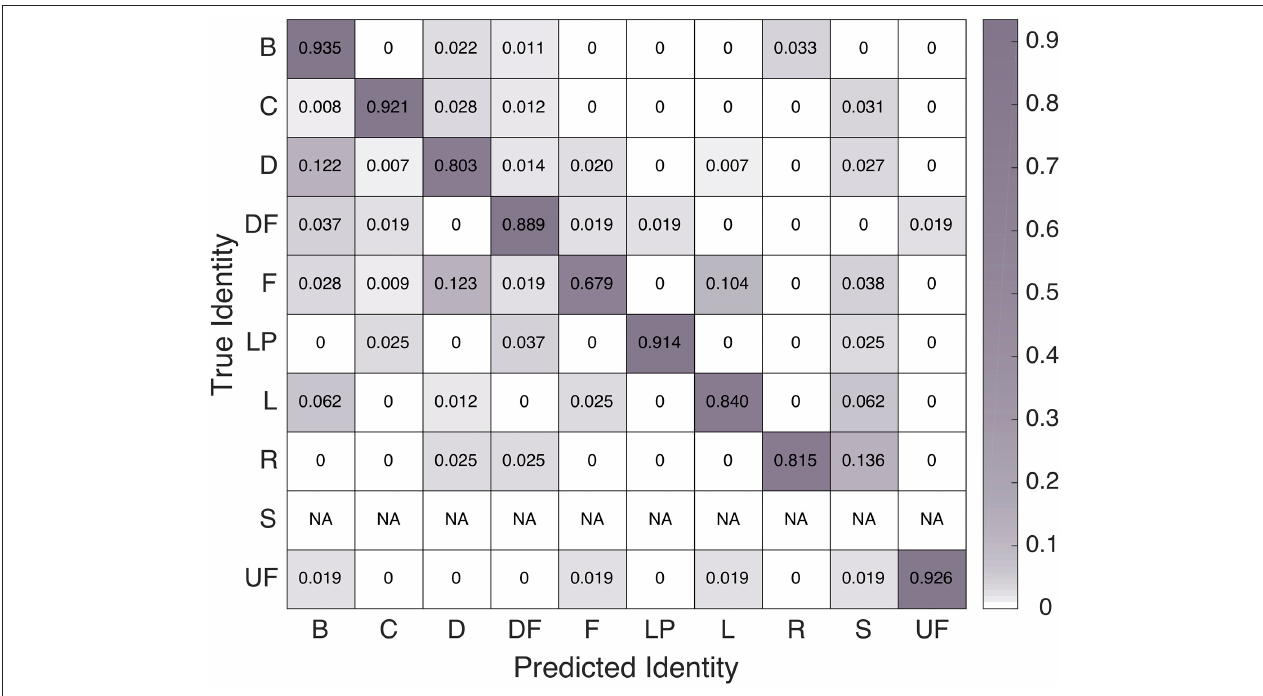
FIGURE 12 | Confusion matrix of the linear SVM classifier’s performance in the real experiment setting, after the four mentioned pre-processing